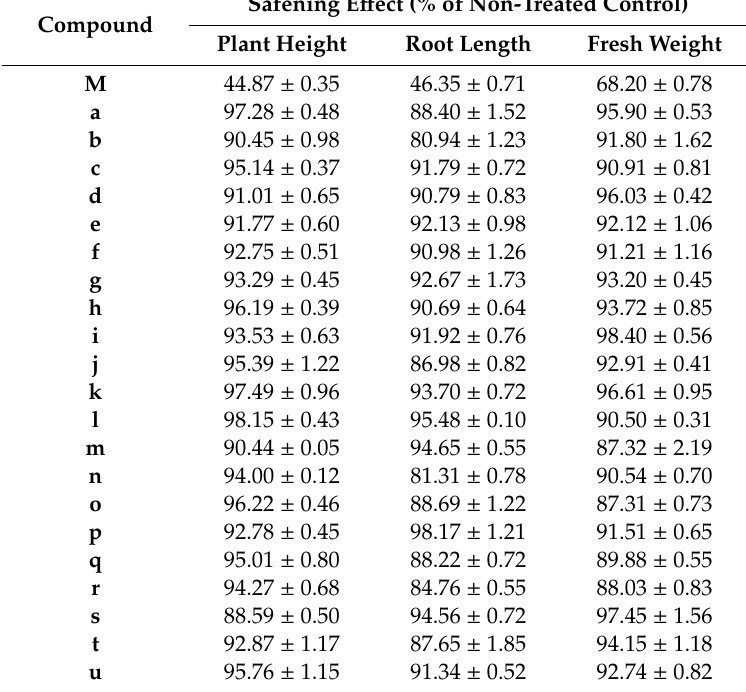
Table 1. Phytotoxicity of 8 mg L − 1 salicylic acid (SA) and substituted SAs on rice plant height, root length, and fresh